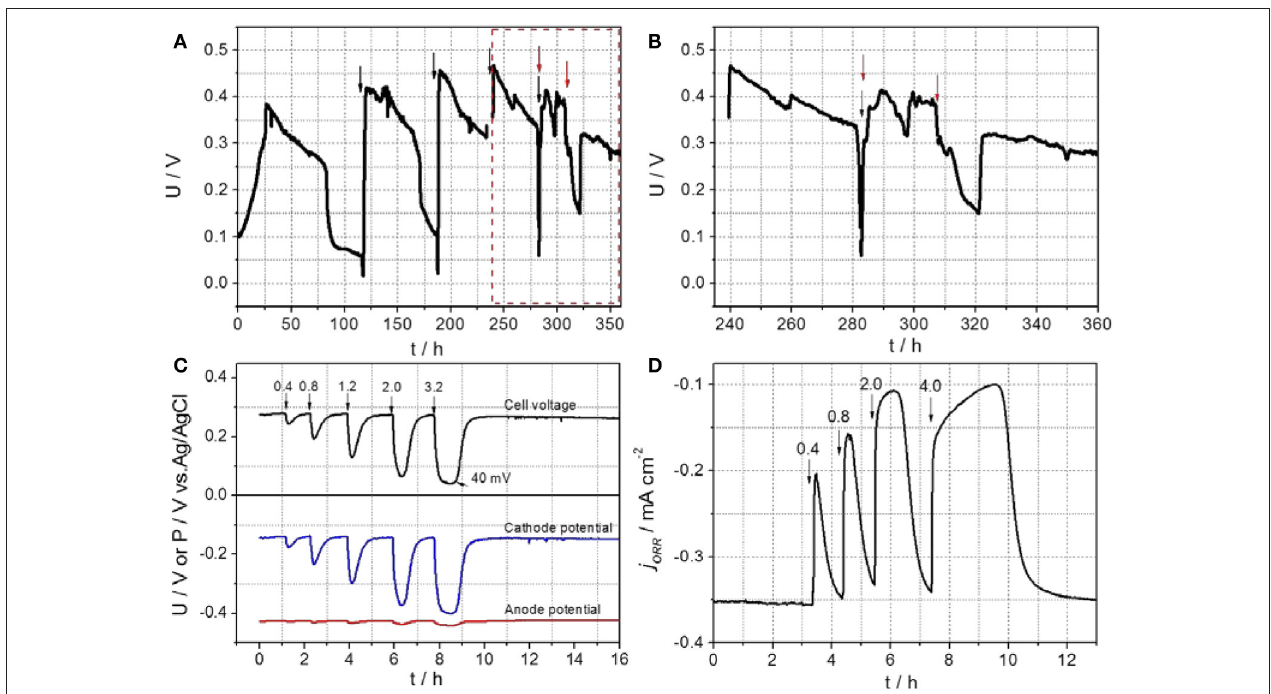
FIGURE 2 | (A,B) Cell voltage curves of the air-cathode MFC during the start-up and biofouling development process; plane (B) is magnified from the dashed plane in (A) . The black and red arrows represent the refreshment of anolyte and catholyte solutions, respectively. Substrate crossover effect results of the rotating bio-GB/NPC-AC; (C) profiles of cell voltage along with cathode and anode potentials of the MFC in response to 0.4–3.2mM acetate additions, and (D) Chronoamperogram recorded in air at a constant potential of − 0.3V vs. Ag/AgCl (sat. KCl). Arrows and numbers indicate injection of acetate solutions with different mM